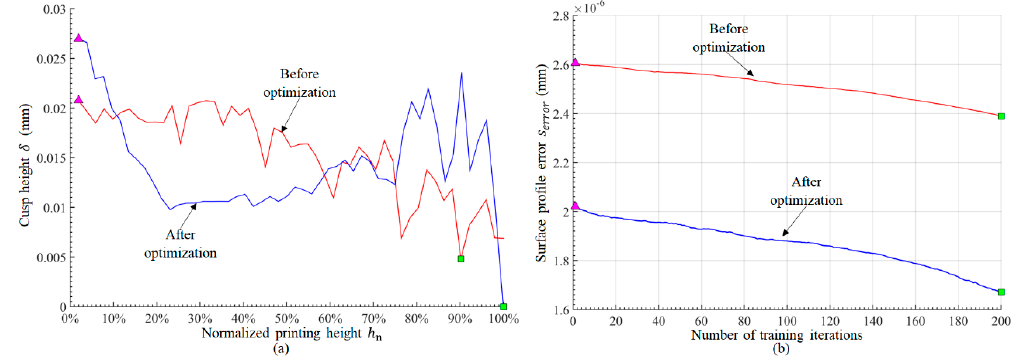
Figure 10. Virtual printing using Digital Twins considering manufacturing error where ( a ) is regarding uniform slicing; ( b ) is regarding adaptive slicing.